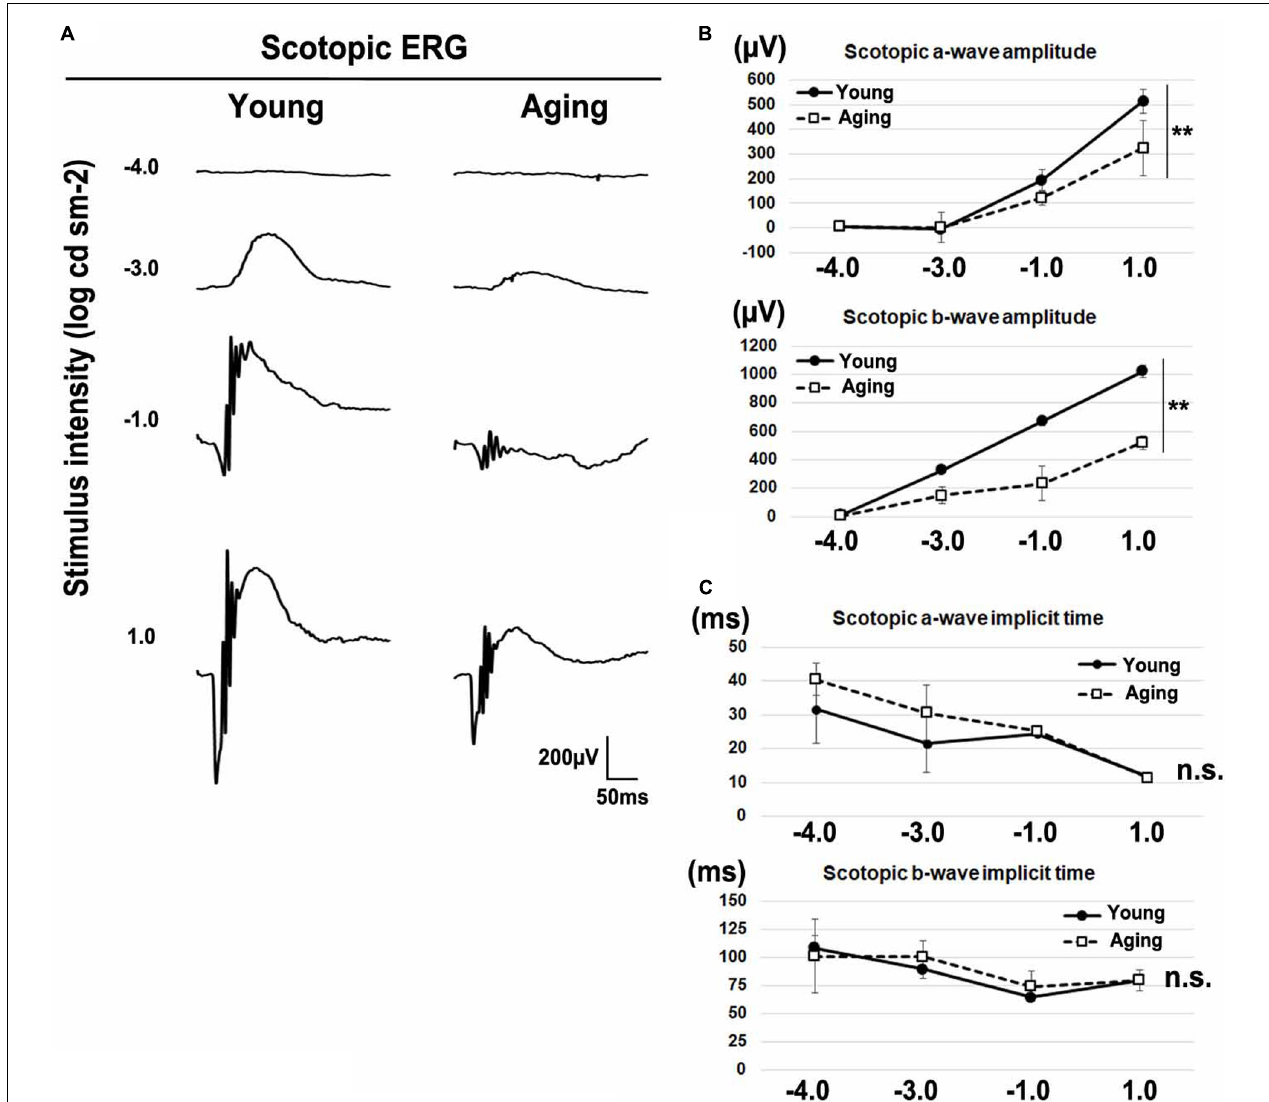
FIGURE 2 | Scotopic ERGs in the aging mice. (A) Representative dark-adapted (scotopic) ERGs in the young adult and aging mice induced by four different stimulus intensities (–4.0, –3.0, –1.0, and 1.0 log cd s/m 2 ). (B) The amplitudes of scotopic a- and b-waves are presented as a function of the stimulus intensity. (C) The implicit times of scotopic a- and b-waves are presented as a function of the stimulus intensity. Error bars, mean ± SD ( n = 3 mice). Two-way repeated measures ANOVA (** p < 0.01, n.s., not significant).